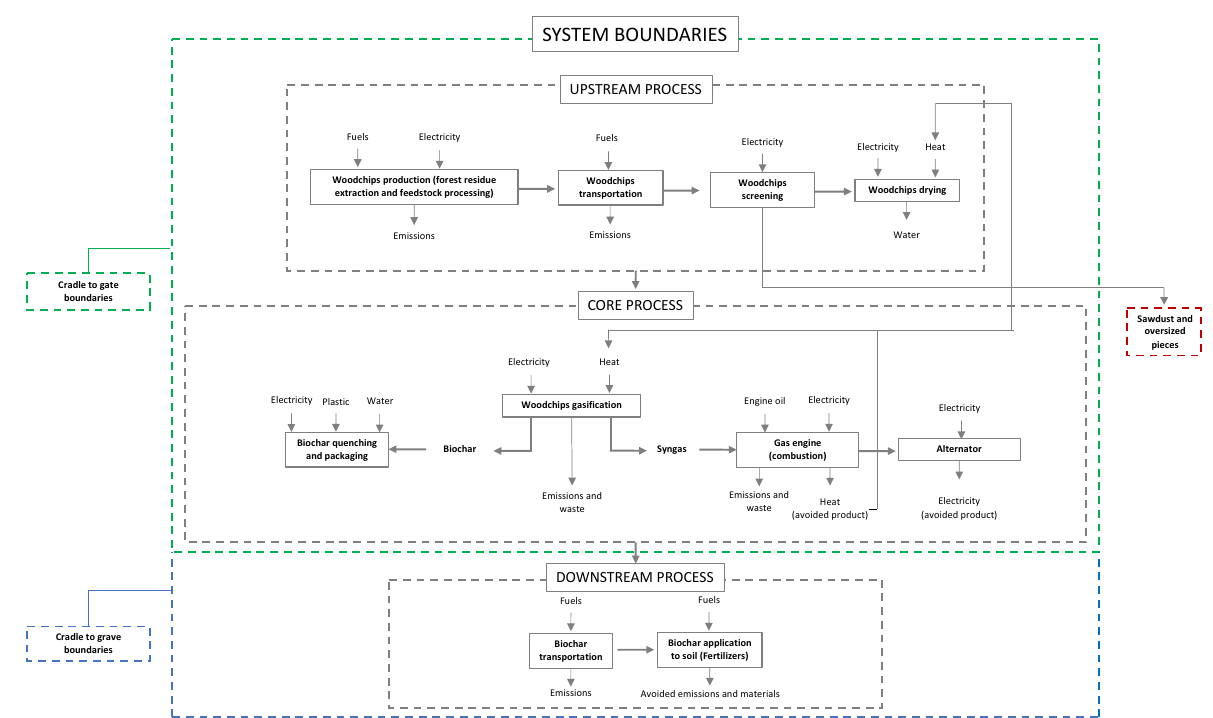
Figure 2. System boundaries and flowchart of the process investigated. The green box represents what is included in the cradle-to-gate boundaries; the blue box represents the system boundaries for the cradle-to-grave analysis; the red box represents what is not included in this analysis.